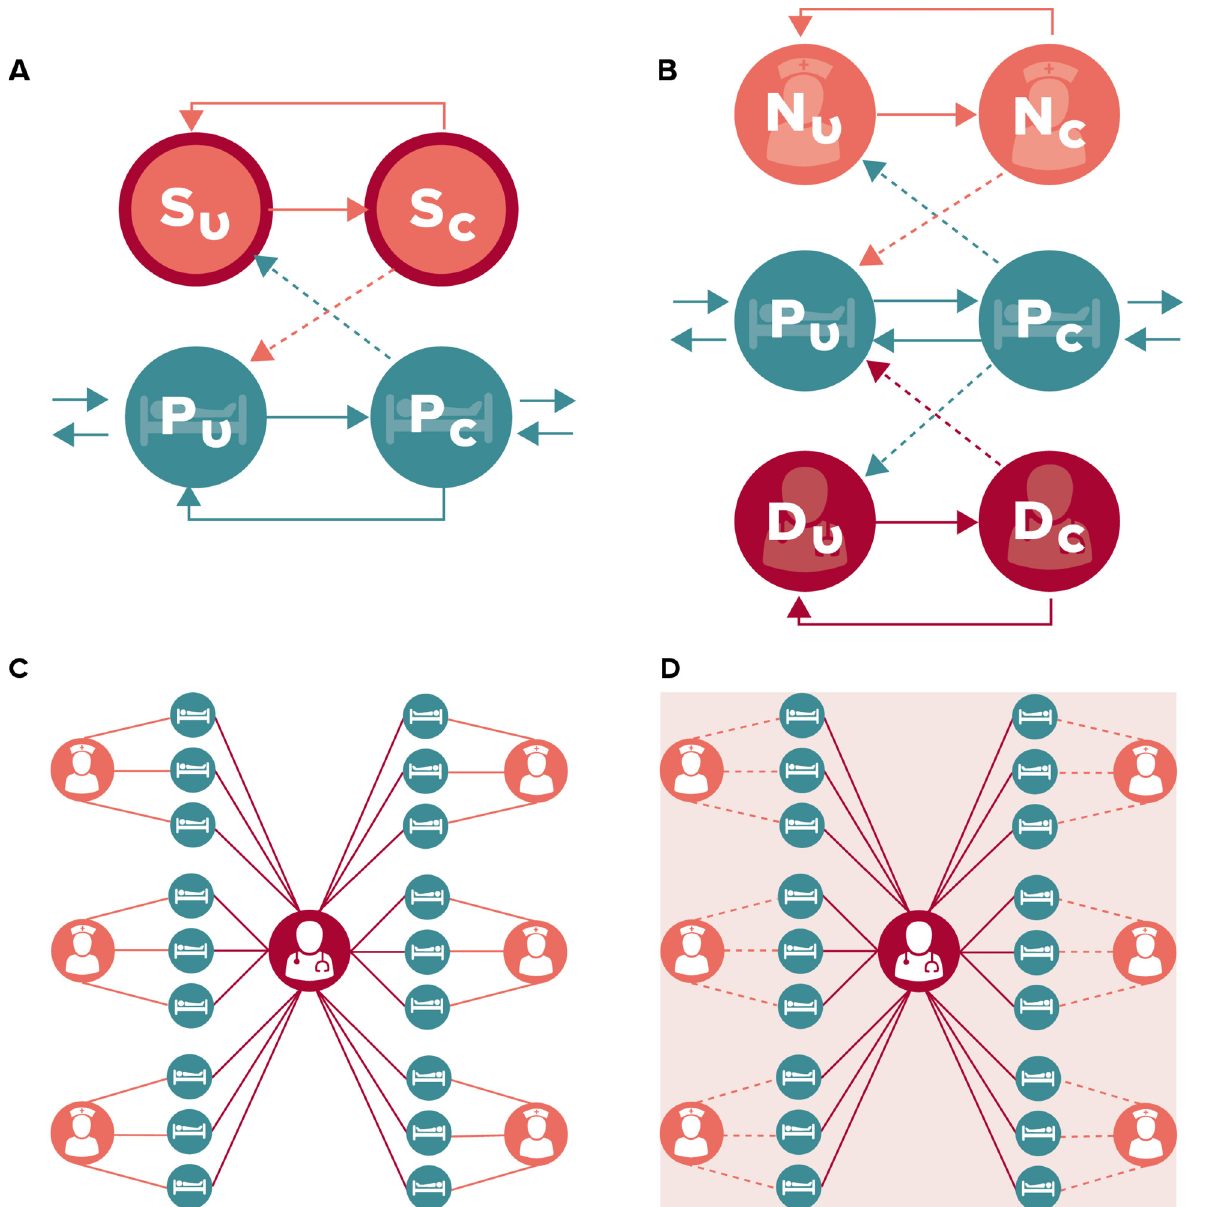
Fig 1. Compartment models of methicillin-resistant Staphylococcus aureus (MRSA) acquisitions. Patients and hospital staff are classified as (un) colonized or (un)contaminated (U and C on diagrams), respectively. Solid arrows indicate transition states, while dashed arrows indicate routes of MRSA transmission (transition parameters and equations are in Tables 1 and S1, respectively. A) Single Staff Type model, B) Nurse-MD model, C) Metapopulation model, D) a hybrid model where nurses only spend a fraction of their time in their assigned patient groups and otherwise see patients at